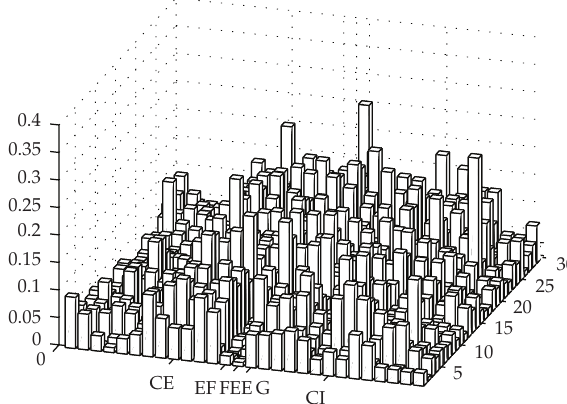
Figure 5: The tra ffi c patterns monitored by the smallest eigenvalue.